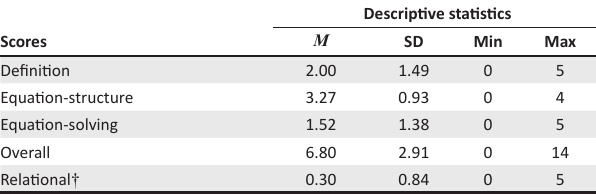
TABLE 2: Descriptive statistics for each